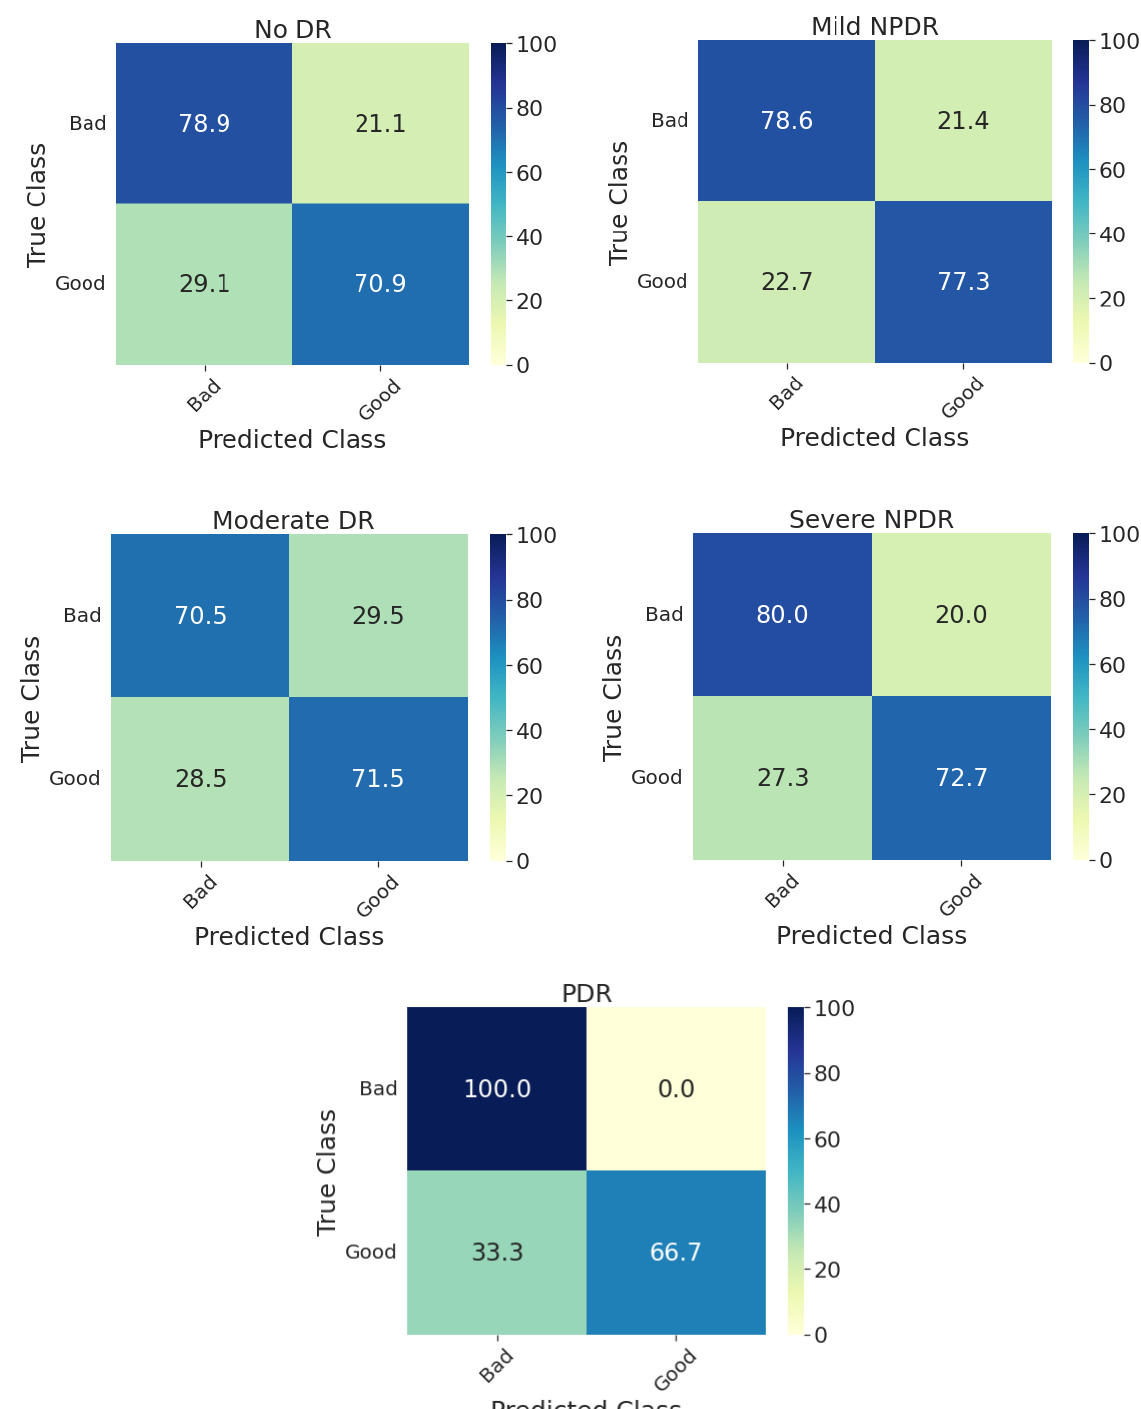
Figure 4. Confusion matrices of the test set for predicting the quality of digital fundus images stratified with respect to DR severity using the ensemble model. DR: diabetic retinopathy, NPDR: non-proliferative diabetic retinopathy, PDR: proliferative diabetic